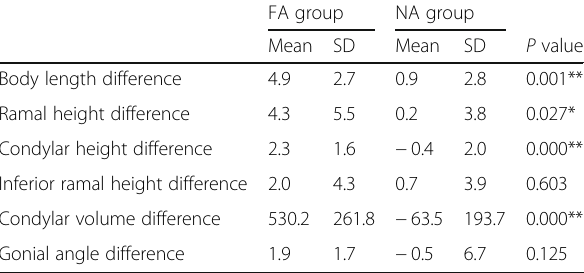
Table 2 Comparison of the bilateral differences in the mandibular components between the FA and NA